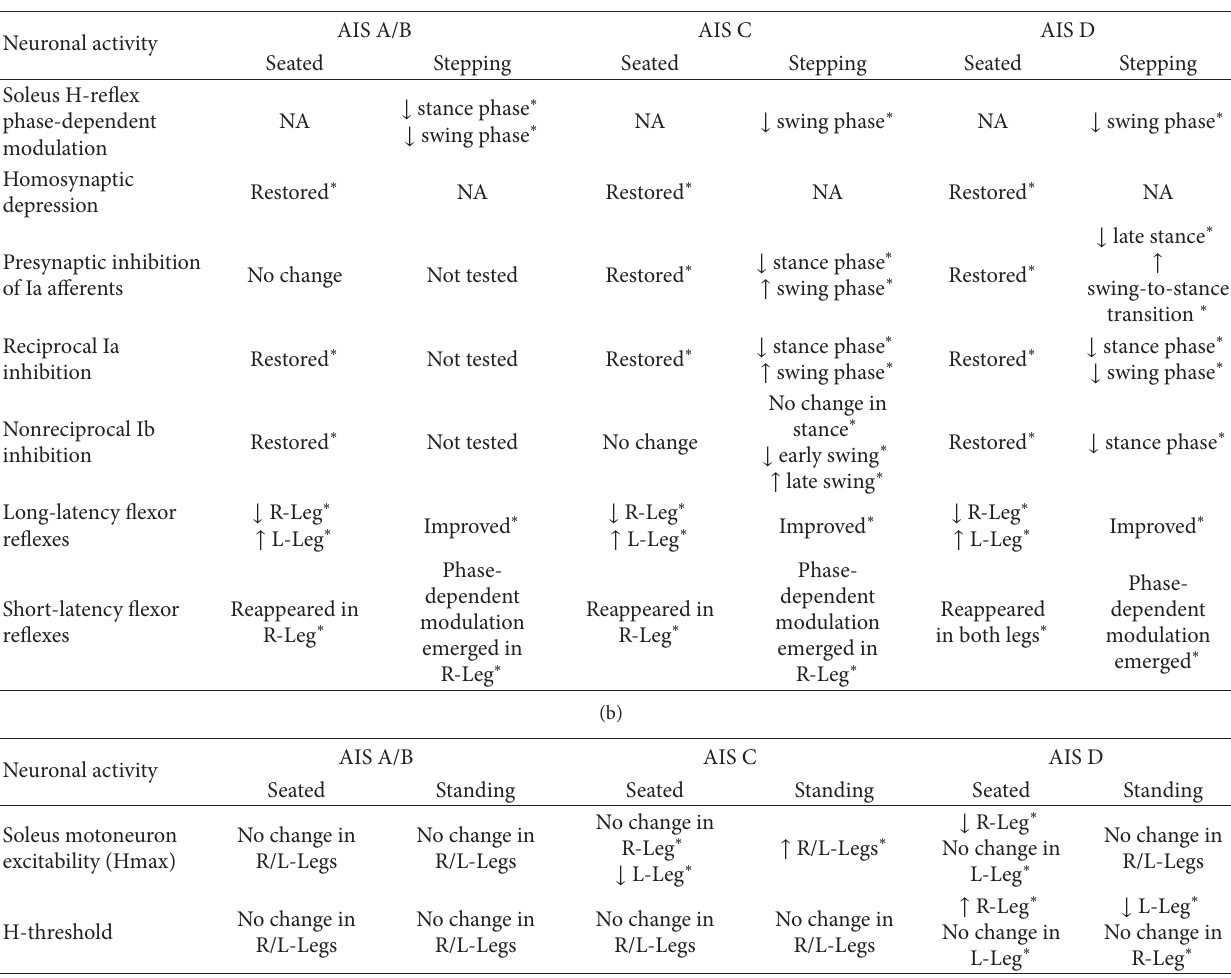
Table 1: Summary of neuronal activity changes in SCI after locomotor training #